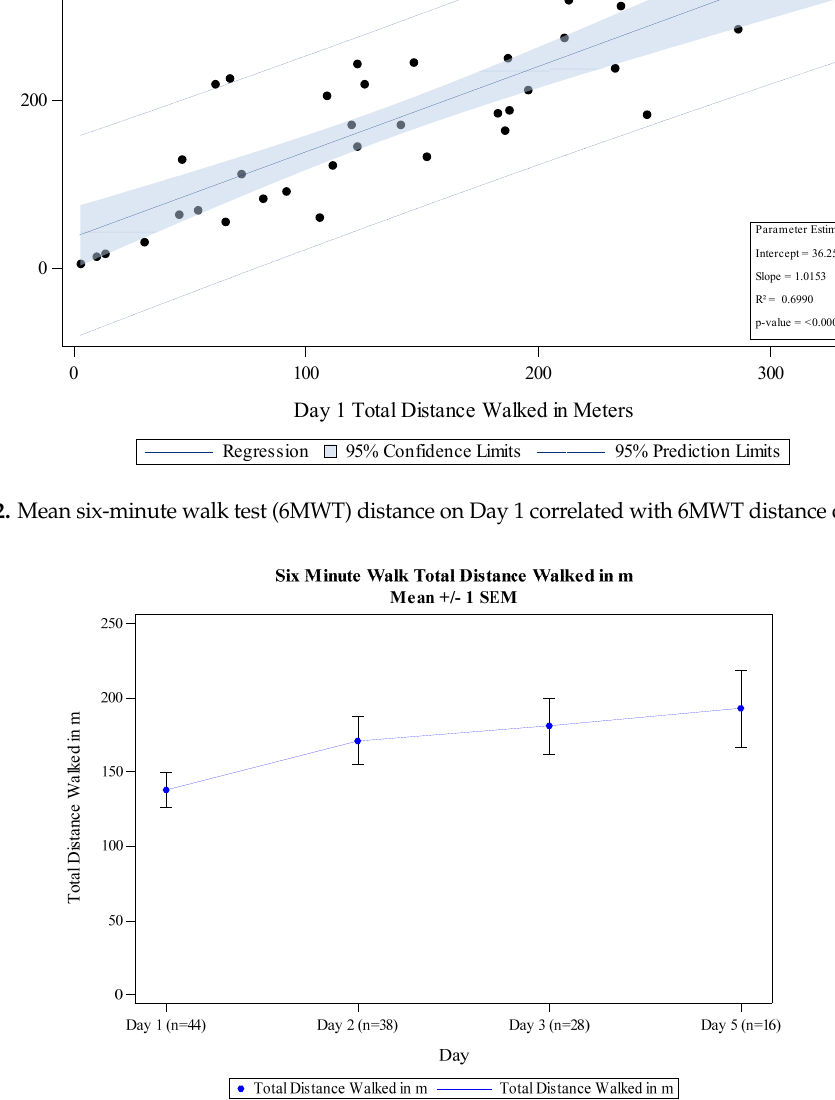
Figure 4. Difference (in meters) between duplicated 6 ‐ min walk tests on Day 3. 3.4. 6MWT Correlation with Biomarkers and Outcomes Day 1 BNP was not correlated with baseline 6MWT total distance ( r 2 = 0.044, p = 0.23) or distance to first stop ( r 2 = 0.047, p = 0.22). Changes in the 6MWT from day 1 to day 3 and changes in BNP over the same time did not correlate. Changes in the total distance and distance to first stop from Day 1 to Day 3 exhibited a non ‐ significant trend toward an inverse correlation with length of stay of the index